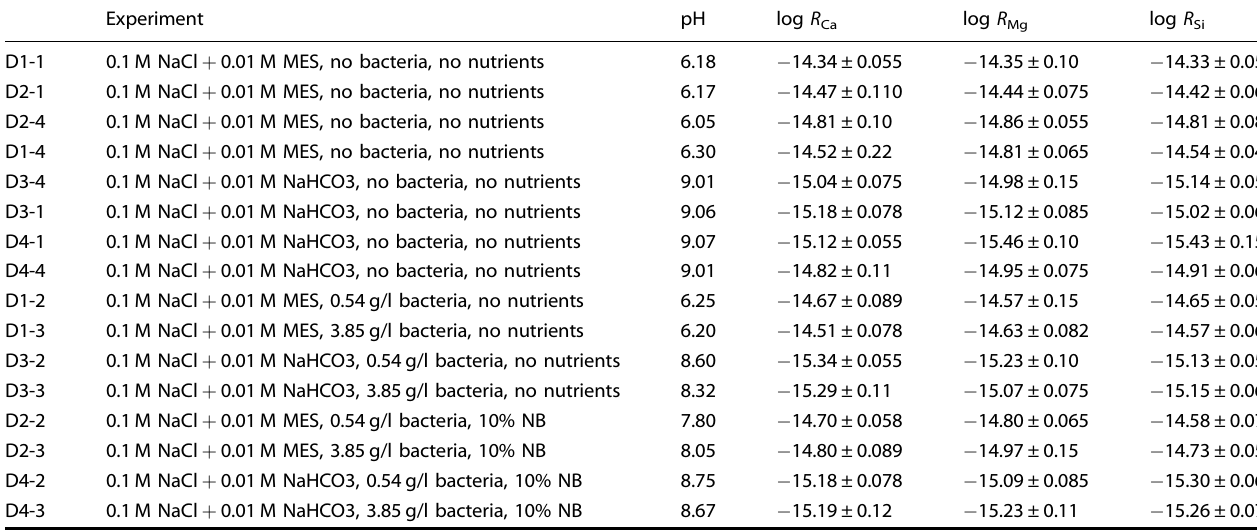
Table 1. Results of Bacterial MFR experiment. R units are mol cm − 2 s − 1 . Experiment